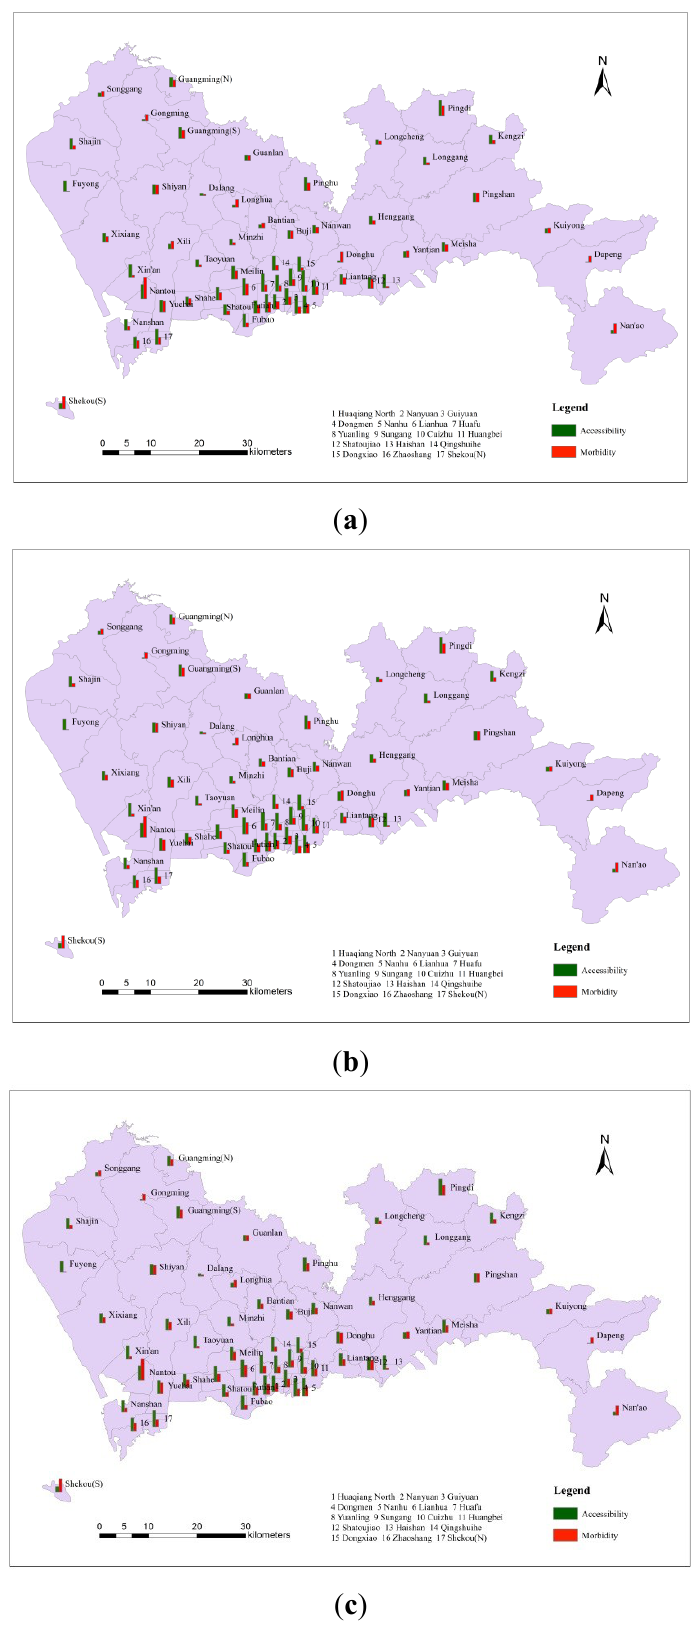
Figure 9. The comparison between spatial access and hepatitis B morbidity. ( a ) Search radiuses: 6, 3, 1.7 km; ( b ) Search radiuses: 9, 4, 2 km; ( c ) Search radiuses: 12, 5, 2.3